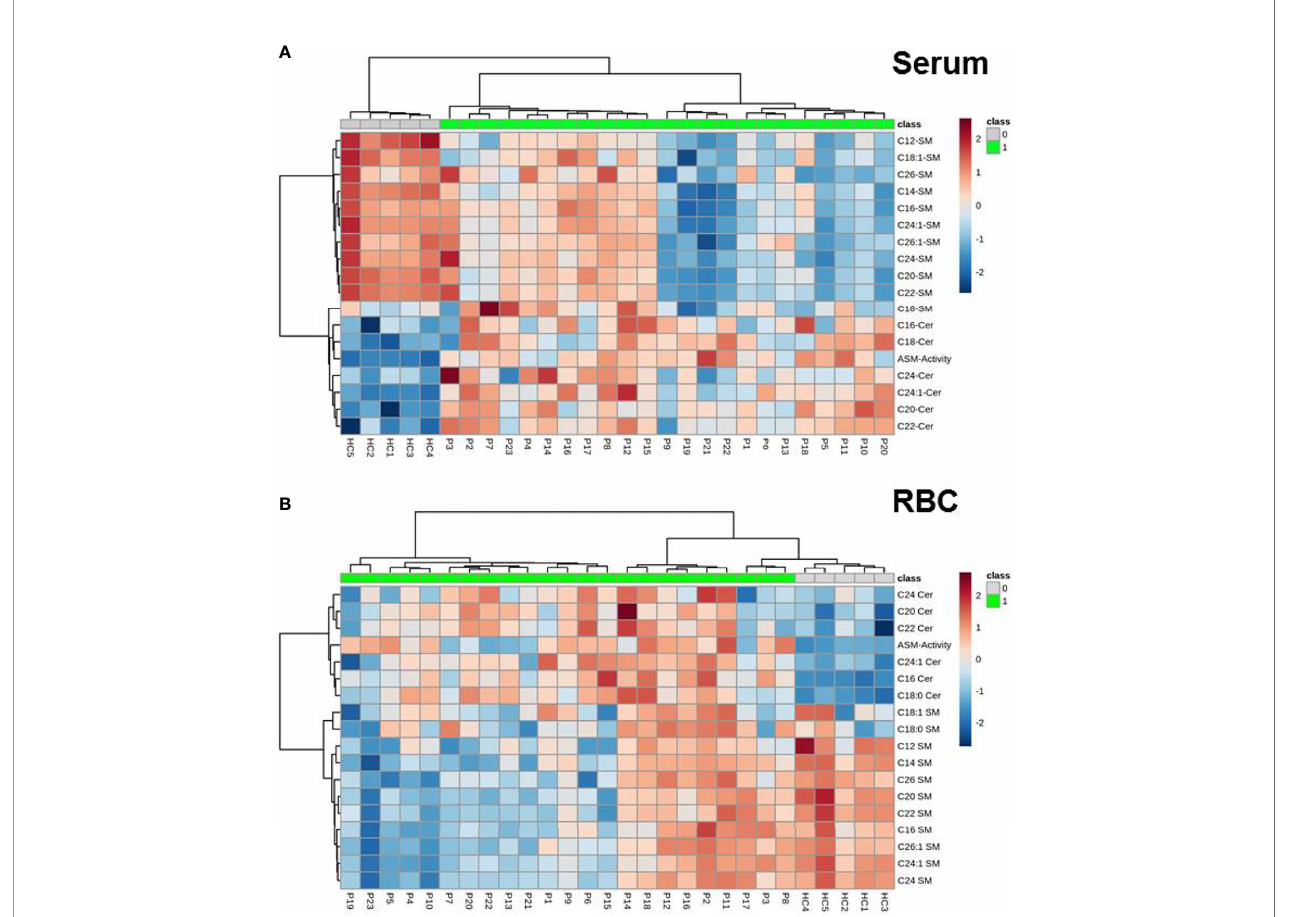
FIGURE 1 | Heatmap of spingolipids (SM and ceramides) as well as ASM activity either in (A) serum and (B) RBC. Shown are hierarchical cluster analyses from data obtained by monitoring the pro fi le of sphingomyelins and ceramides as well as ASM activity (measured in serum samples). Specimen of sphingolipids are given in rows, individual patients samples in columns comparing patients (P1 – P23, marked in green) and healthy controls (HC 1-6, gray). Color code: increase in sphingolipid content is given in red, decrease in blue. Distance measure is given in euclidian